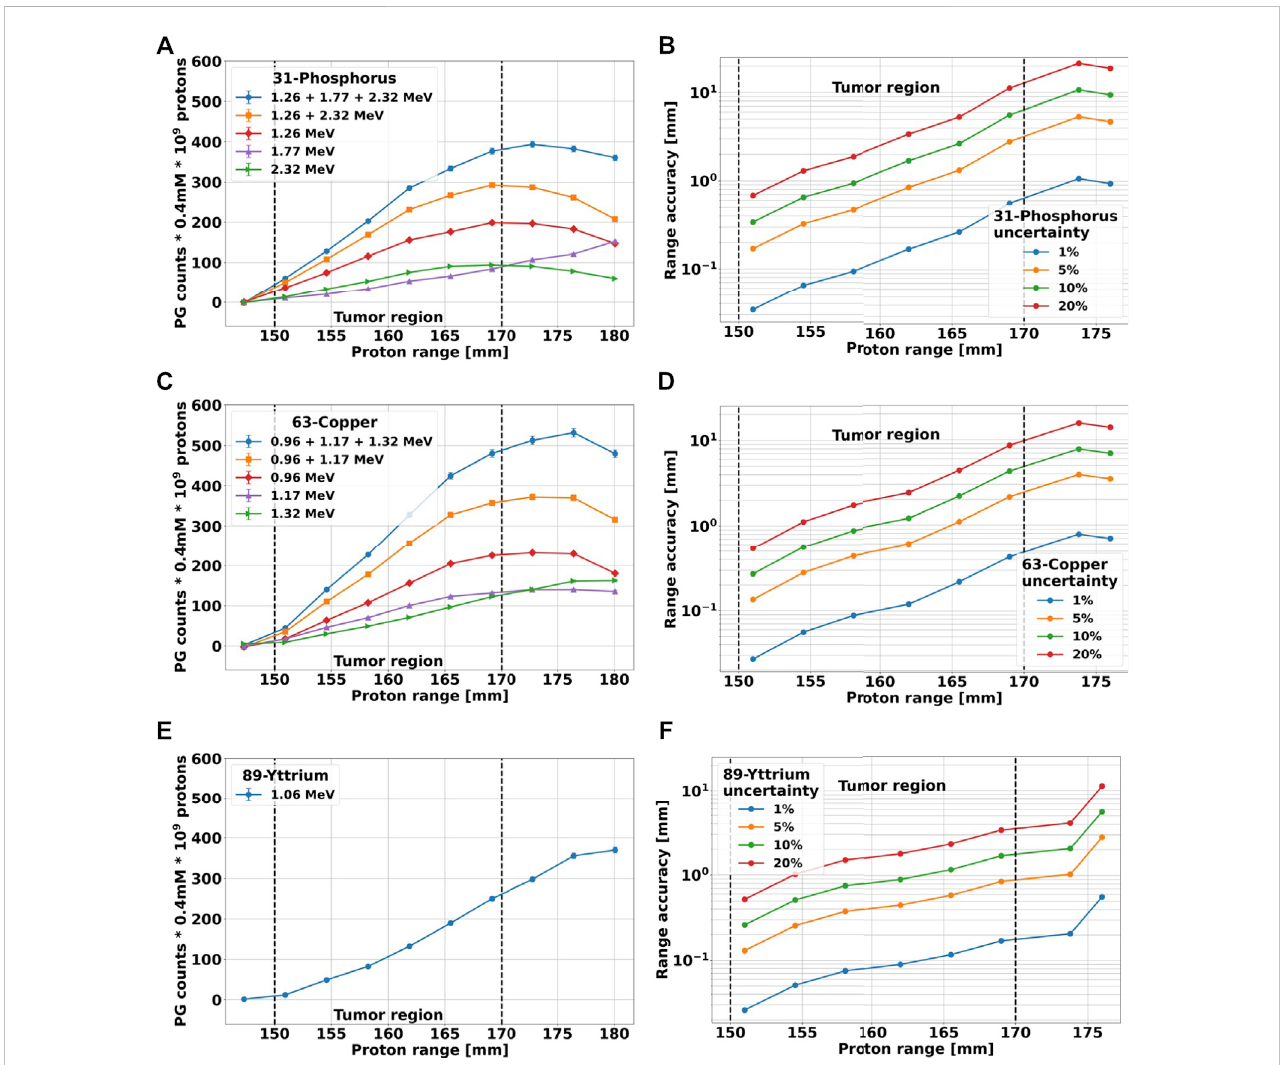
FIGURE 11 (A,C,E) :countsofcharacteristicPGsof 31 P, 63 Cuand 89 Y,respectively,plottedasafunctionofprotonrange.TheresultshavebeenobtainedwithTOPAS, using the geometry described in Section 2.3 for simulating the irradiation of a soft-tissue phantom with protons of different energies. The labeling elements areonlycontainedinthetumor region,heremarkedwithdashedlines. Allsimulationswereruntoachievean uncertainty below1%,but thecountshavebeen scaled to 10 9 incoming protons and a 0.4 mM element concentration. The background produce by soft tissue has been subtracted. (B, D, F) : Proton range accuracy versus range calculated from the cumulative blue curves of (A, C, D) when different percentage errors on the PG count are